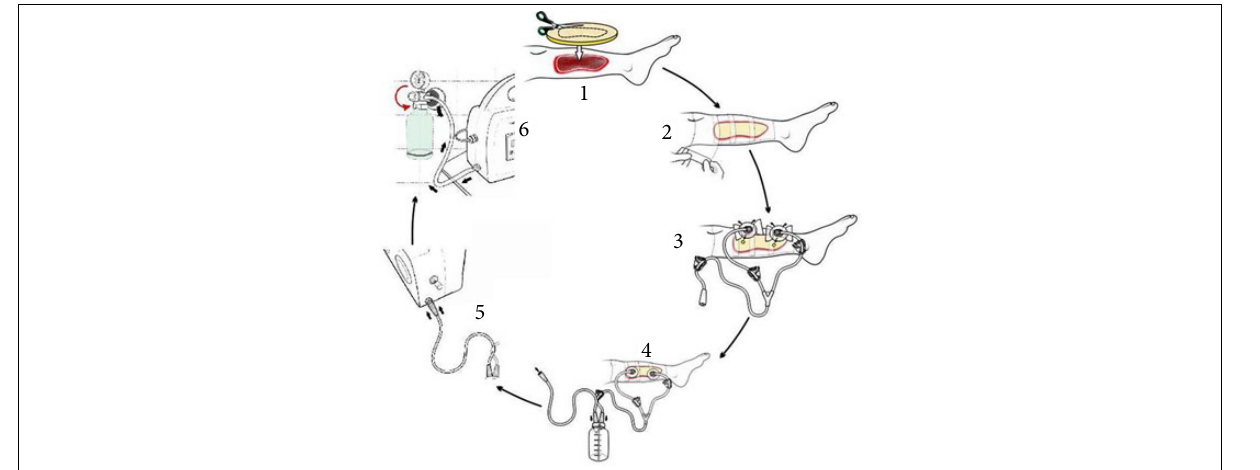
Figure 2 - Applying the SVDM. (1) Cutting and placing the foam on the lesion; (2) Sealing the foam using a transparent polyurethane adhesive film; (3) Placing suction cups on one or two holes (2 cm) made in the film on the foam; (4) Suction tube connection to the liquid collection canister; (5) Connection of the canister to the control unit; (6) Activation of the SVDM and adjustment of the subatmospheric pressure.